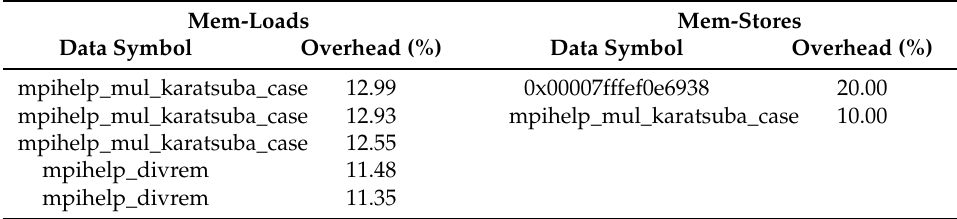
Table 2. Results of Flush+Reload attacking RSA.